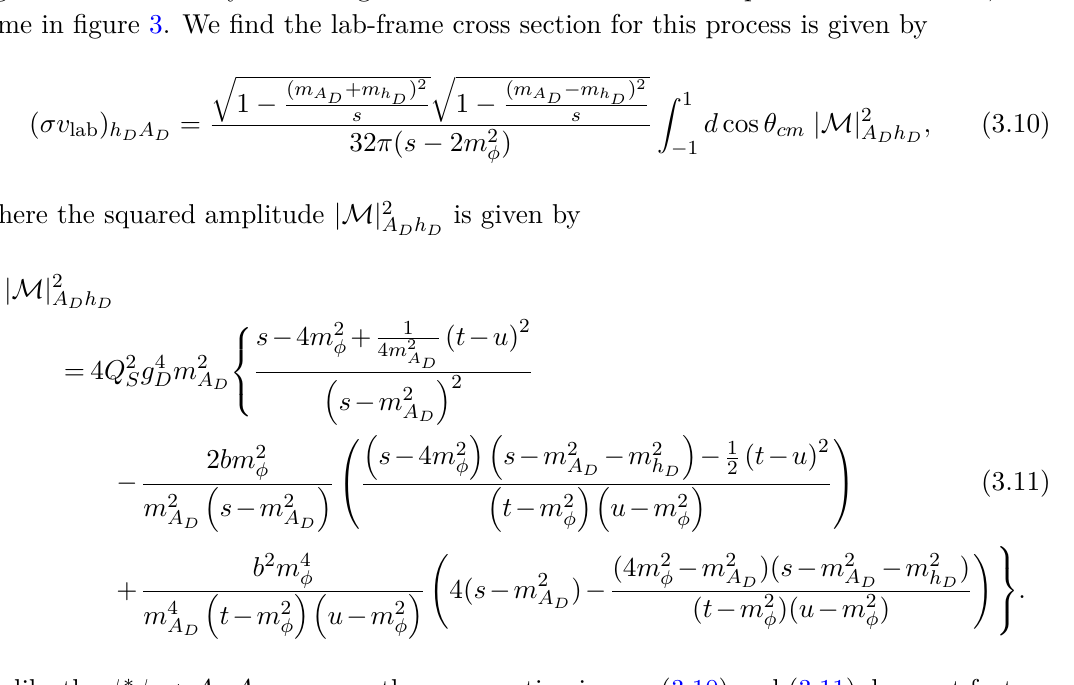
Figure 2. The Feynman diagrams which contribute to the φ Note the presence of the fourth diagram, which emerges from the s -channel exchange of the dark Higgs scalar h D